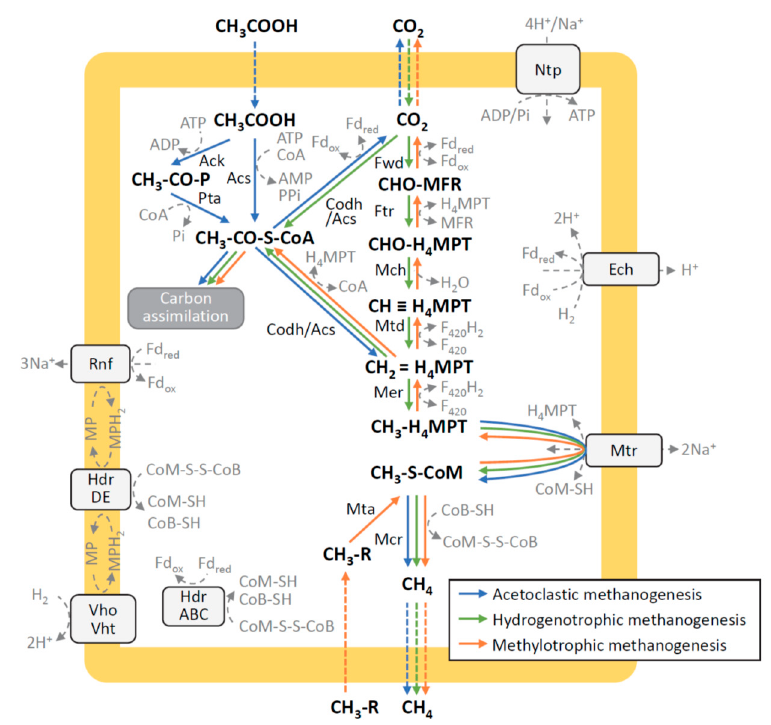
Figure 1. Central catabolic pathways in methanogens. Arrows are color-coded according to types of methanogenesis. Catabolic steps widely distributed to respective types of methanogens are included. Abbreviations are as follows: Fdox/Fdred, oxidized and reduced ferredoxin; MP/MPH2, oxidized and reduced methanophenazine; CoB-SH, coenzyme B; CoM-SH, coenzyme M; CoM-S-S-CoB, mixed disulfide of CoM-SH and CoB-SH; F420/F420H2, oxidized and reduced factor 420; H4MPT, tetrahydromethanopterin; Fwd, formylmethanofuran dehydrogenase; Ftr, formylmethanofuran:H4MPT formyltransferase; Mch, methenyl-H4MPT cyclohydrolase; Mtd, F420-dependent methylene-H4MPT dehydrogenase; Mer, methylene-H4MPT reductase; Mtr, methyl-H4MPT:coenzyme M methyltransferase; Mcr, methyl-coenzyme M reductase; Hdr, heterodisulfide reductase; Ech, energy-converting hydrogenase; Vho/Vht, F420 non-reducing hydrogenase; Acs, acetyl-CoA synthetase; Ack, acetate kinase; Pta, phosphotransacetylase; Codh/Acs, CO dehydrogenase/acetyl-CoA synthase; Mta, methyltranferase; Ntp, proton or sodium-translocating ATPase; Rnf, sodium-translocating complex.